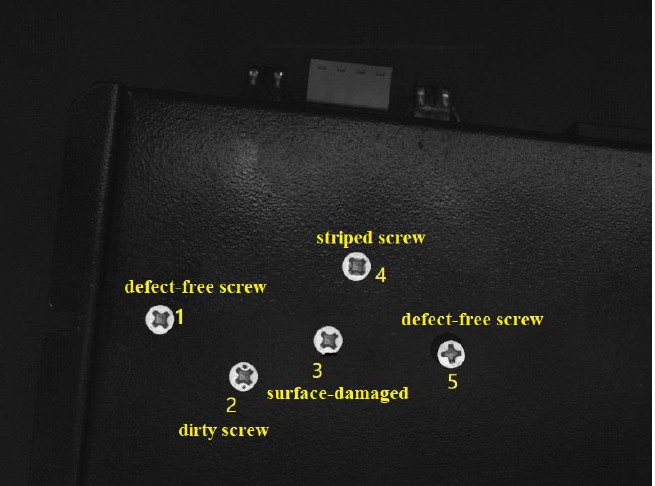
Figure 14. Screws for testing.